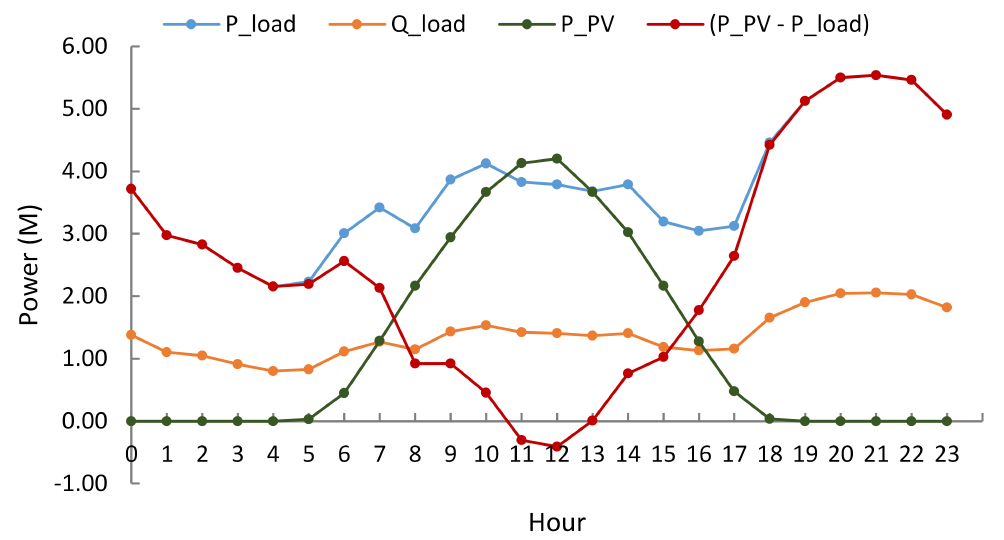
Figure 3. Generationand load curve of the 33-bus test system. Table 2. Cases analyzed in the 33-bus test